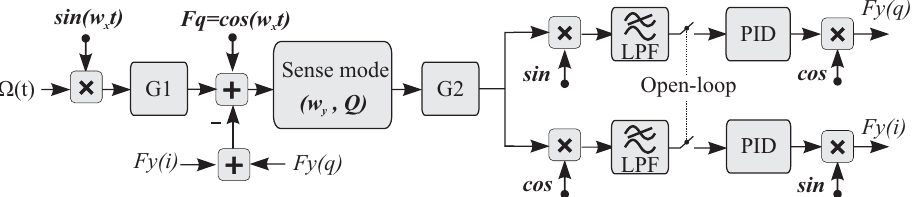
Figure 18. Simplified block diagram of the open-loop and closed-loop rate QMG MEMS